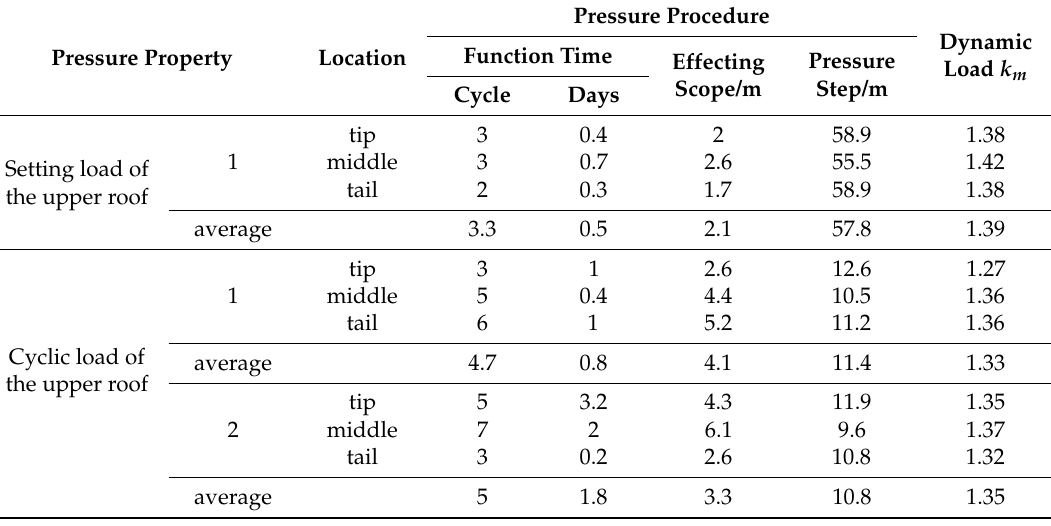
Table 4. Pressure step and strength of the main roof.